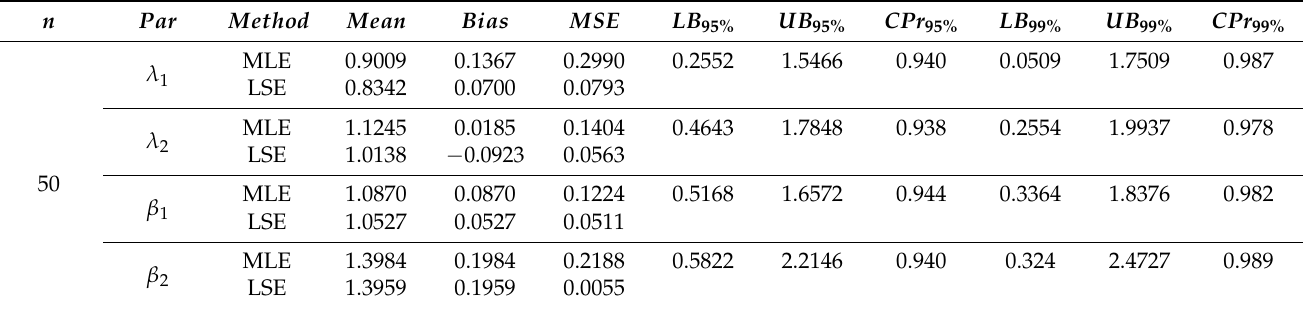
Table 3. The results of MLEs, LSEs, interval estimates, and CPrs when β 1 = 1, β 2 = 1.2, λ 1 =